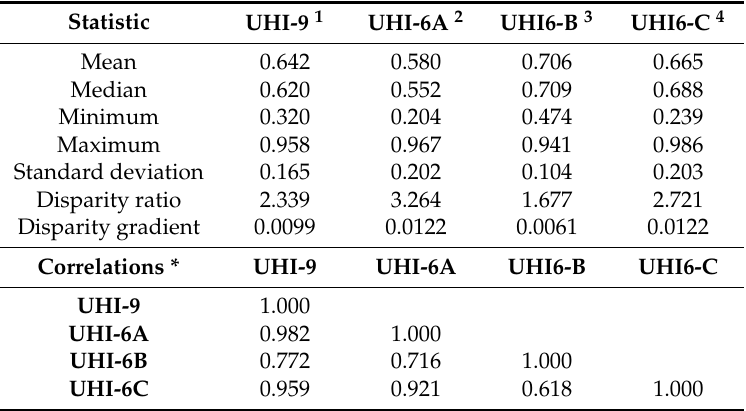
Table 1. Summary statistics for the four Urban Health Indices that compare the 57